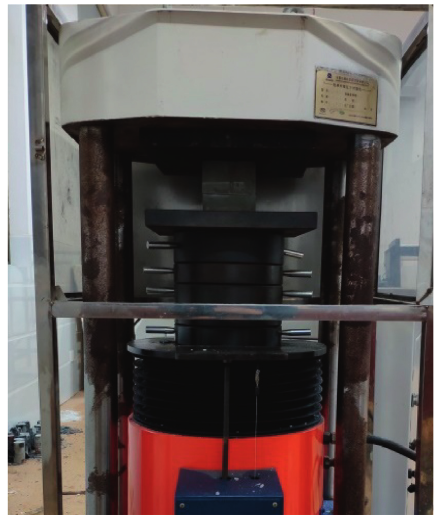
Figure 3: Loading process of backfill